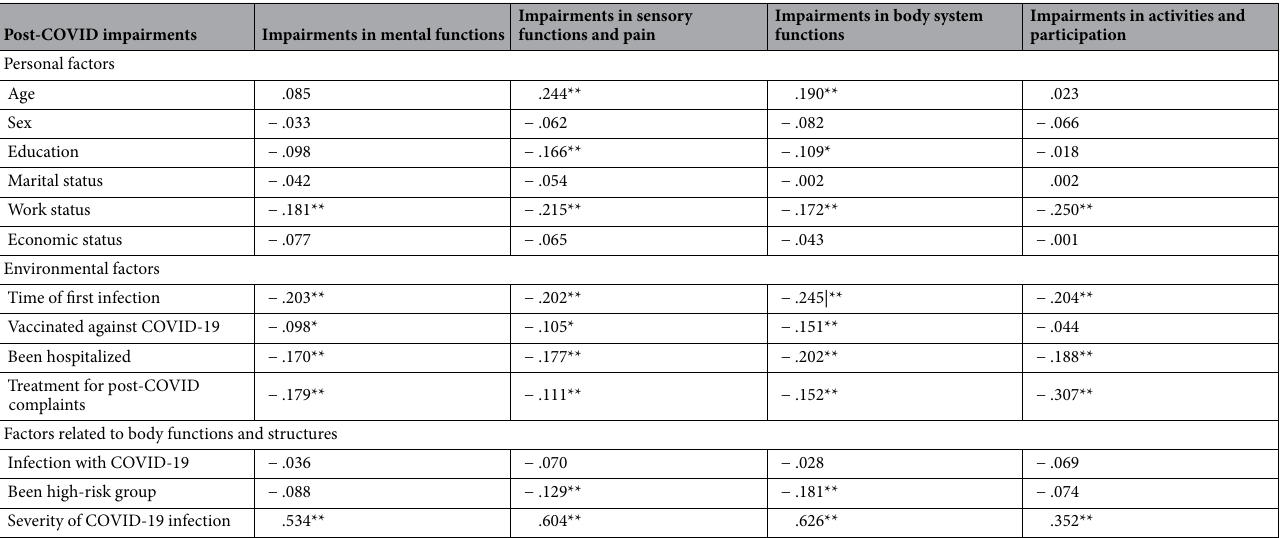
Table 3. Pearson correlations between related factors and post-COVID impairments. * p < .05, ** p <